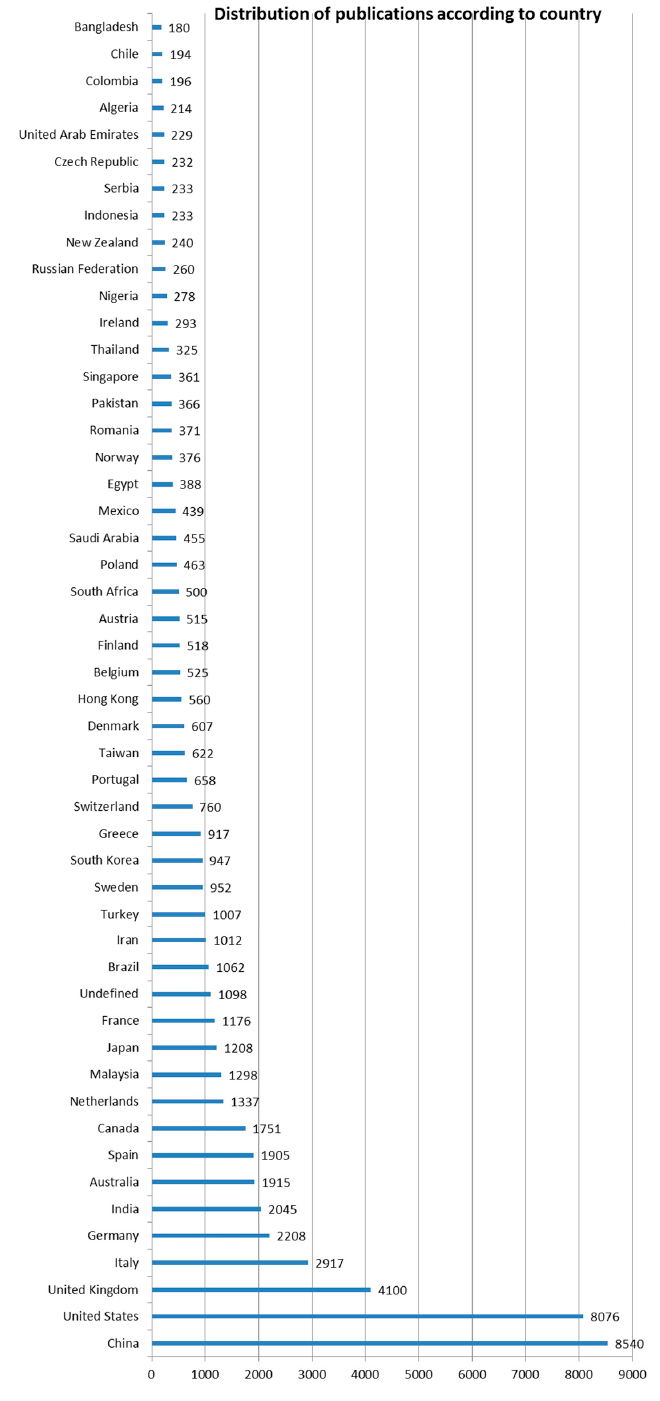
Figure 5. Scientific production for the top 50 contributing countries.